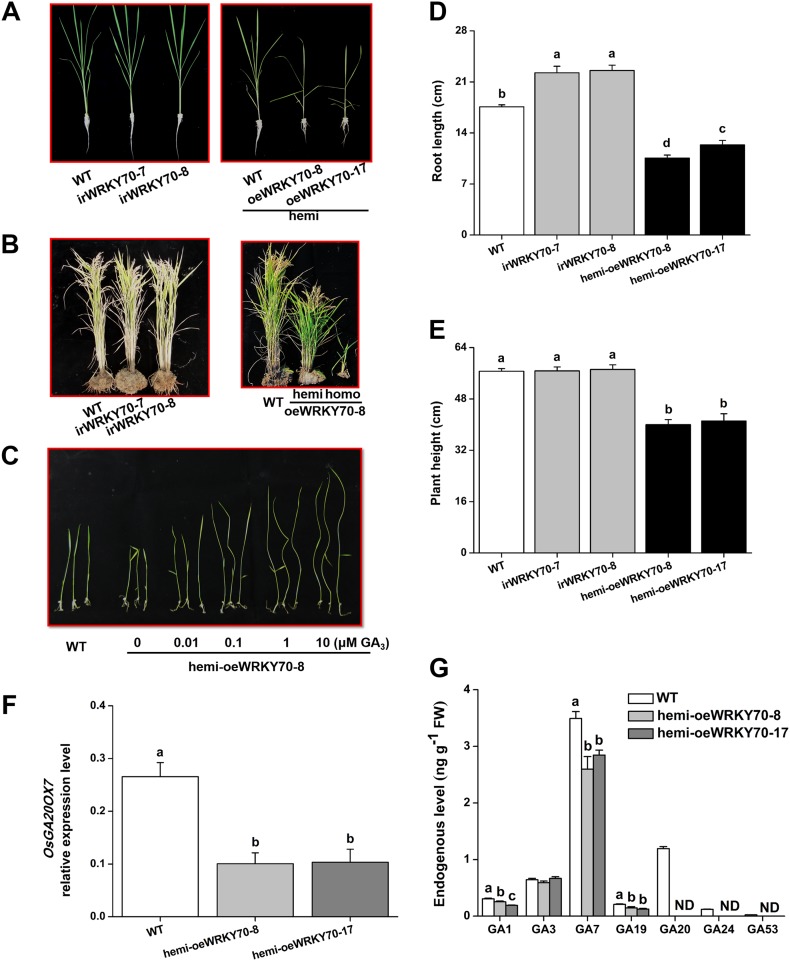
Altering OsWRKY70 expression affects GA levels and plant growth.(A, B) Growth phenotypes of OsWRKY70 transgene lines (irWRKY70 lines, irWRKY70-7 and irWRKY70-8, and oeWRKY70 and hemi-oeWRKY70 lines, oeWRKY70-8, hemi-oeWRKY70-8 and hemi-oeWRKY70-17) and wild-type (WT) plants at tillering stage (A) and heading stage (B). (C) 10-day-old seedlings of WT and hemi-oeWRKY70-8 lines whose seeds were surface sterilized and placed on 1/2 Murashige and Skoog agar medium containing GA3 (minimum purity > 99%, Sigma, St Louis, MO) at various concentrations. This experiment was repeated 3 times with similar results. (D, E) Root length (D) and plant height (E) of transgenic lines with silencing (irWRKY70) or overexpressing (hemizygous lines, hemi-oeWRKY70 lines) of OsWRKY70 and WT plants at tillering stage. (F) Mean transcript levels (+SE, n = 5) of OsGA20ox7 in hemi-oeWRKY70-8, hemi-oeWRKY70-17, and WT plant. (G) Mean levels (+SE, n = 3) of gibberellins (GAs), including GA1, GA3, GA7, GA19, GA20, GA24, and GA53, in hemi-oeWRKY70-8, hemi-oeWRKY70-17, and WT plants. Letters indicate significant differences among different lines (p < 0.05, Duncan's multiple range test).